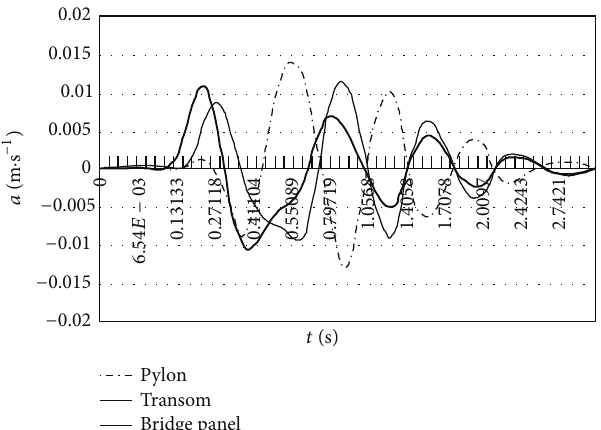
Figure 6: Acceleration data at 125 meters point.